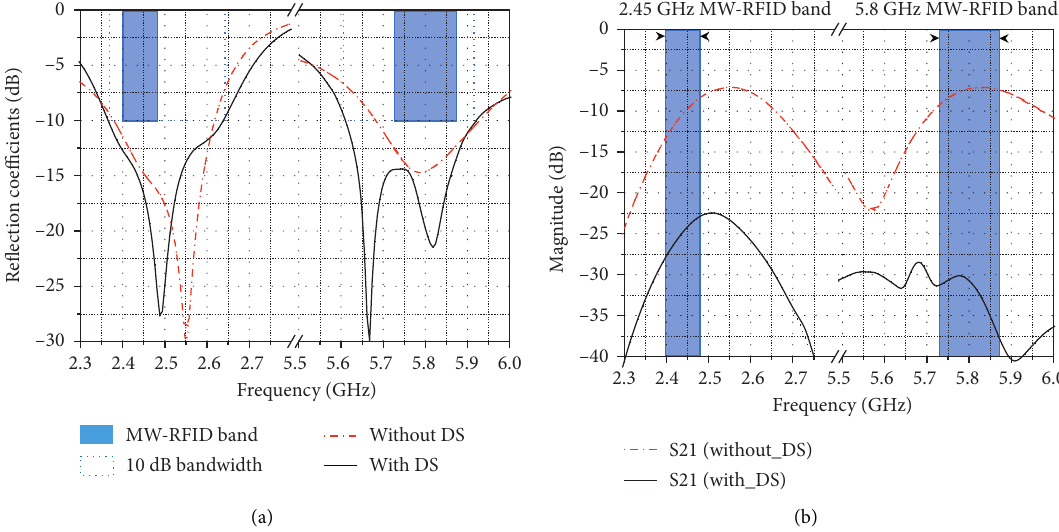
Figure 3: (a) Reflection coefficients and (b) mutual coupling of the antenna with decoupling structure (DS) and without